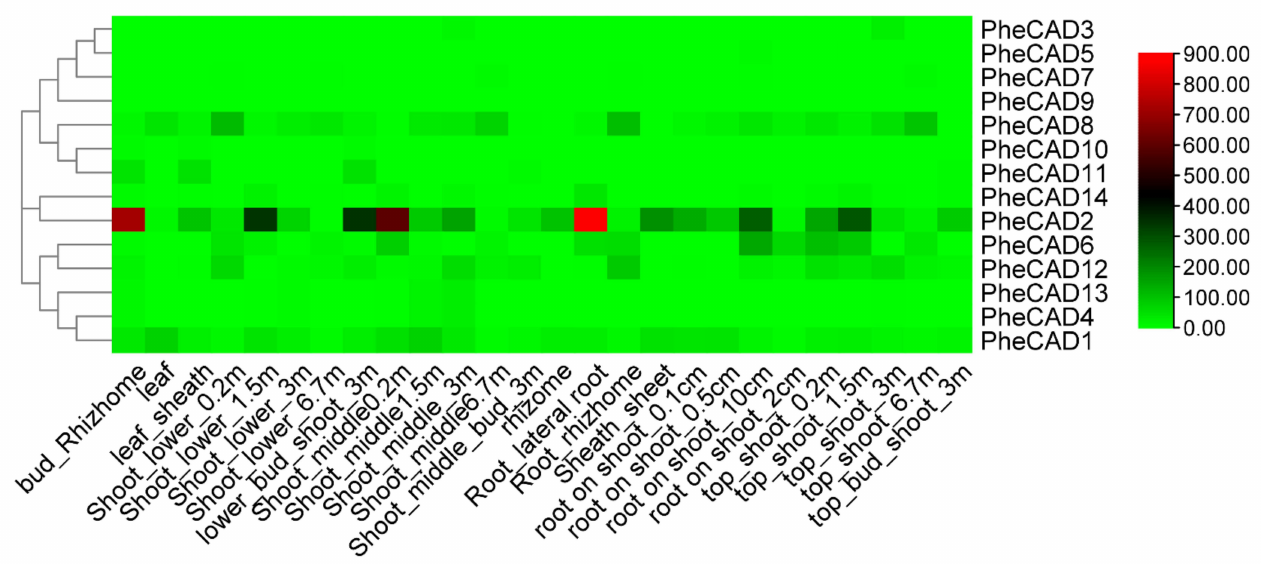
Figure 3. Expression heatmap of PheCAD genes in 26 different kinds of tissues and stages of bamboo development. The log2 expression values are depicted in colour shades from red (highest) to green